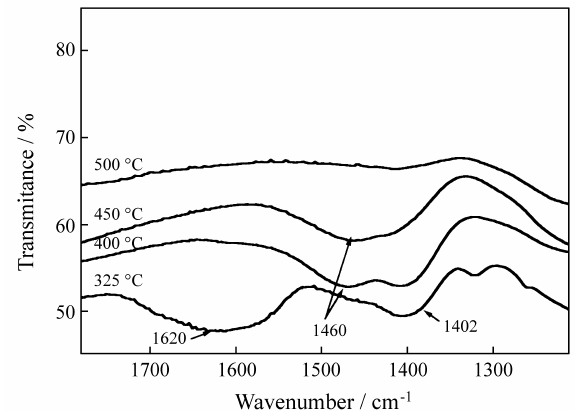
Figure 6. FT-IR spectra of a thin film heat treated at different tempera- tures.